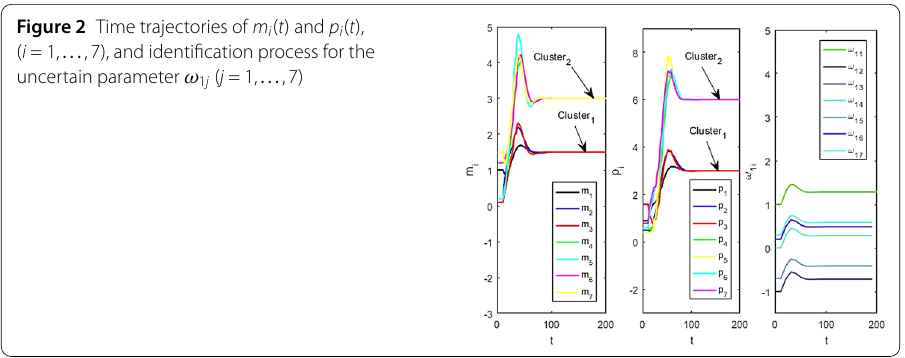
Figure 2 Time trajectories of m i ( t ) and p i ( t ), ( i = 1, ... ,7), and identification process for the uncertain parameter ω 1 j ( j = 1, ...